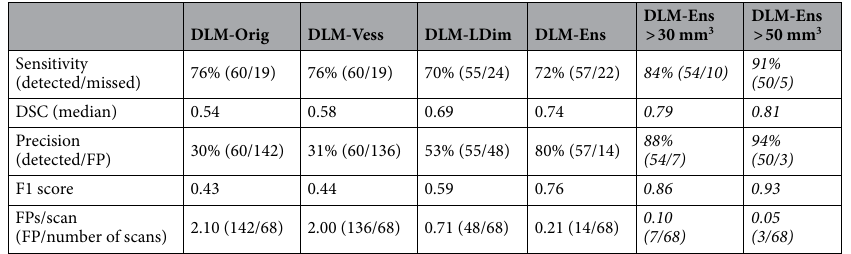
Table 2. Sensitivity, median dice similarity coefficient (DSC), precision, F1 score, and average false positive (FPs)/scan for five-fold-cross-validation results of the different DLMs as well as results for DLM-Ens in relation to aneurysm